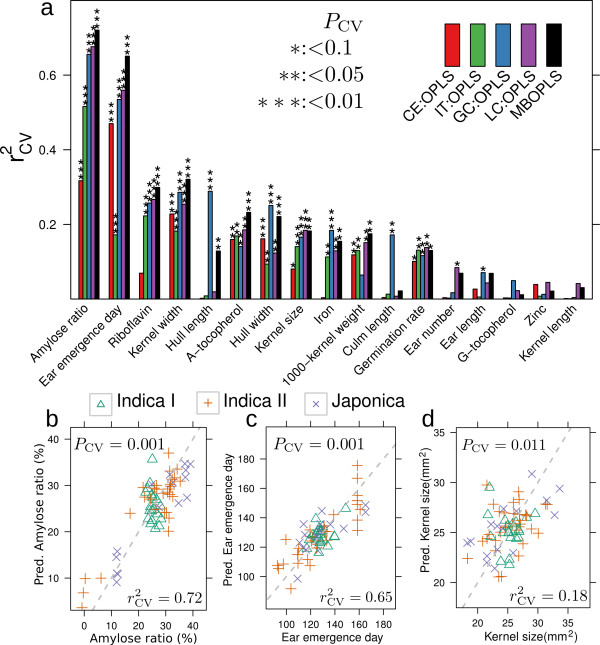
Predicting quality traits from metabolomic composition. (a) The predictive performance of models based on single datasets using OPLS and all datasets together using MB-OPLS. Cross-validation based rCV2 statistics equals 1 for perfect predictions. The stars indicate significance level as estimated by the empirical PCV-value. (b-d) Prediction performance during the median cross-validation run. Grey lines indicate identity.